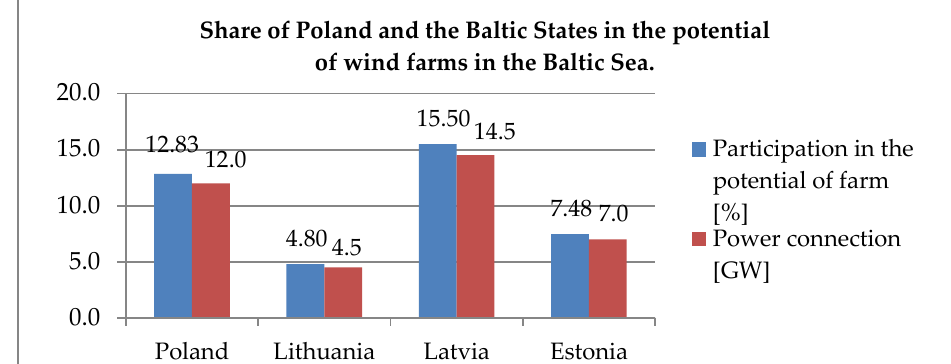
Figure 5. Share of Poland and the Baltic States in the potential of wind farms in the Baltic Sea [68].